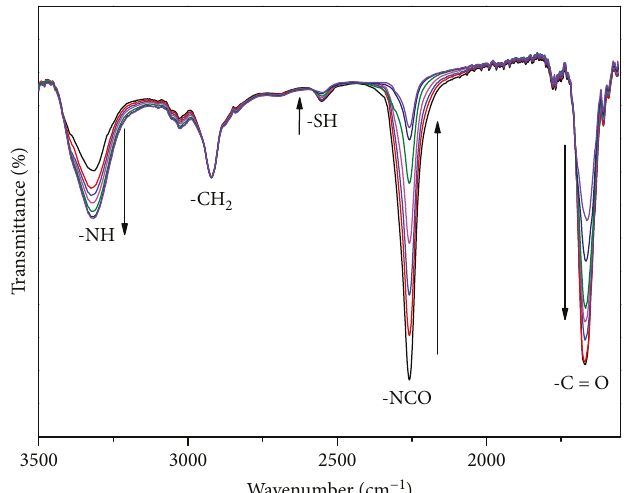
Figure 4: FTIR spectra of PSU with 150 ppm TEA at 105 ° C at di ff erent curing times. (curing time from bottom to top is 5, 7, 10, 15, 20, 30, and 40 min).